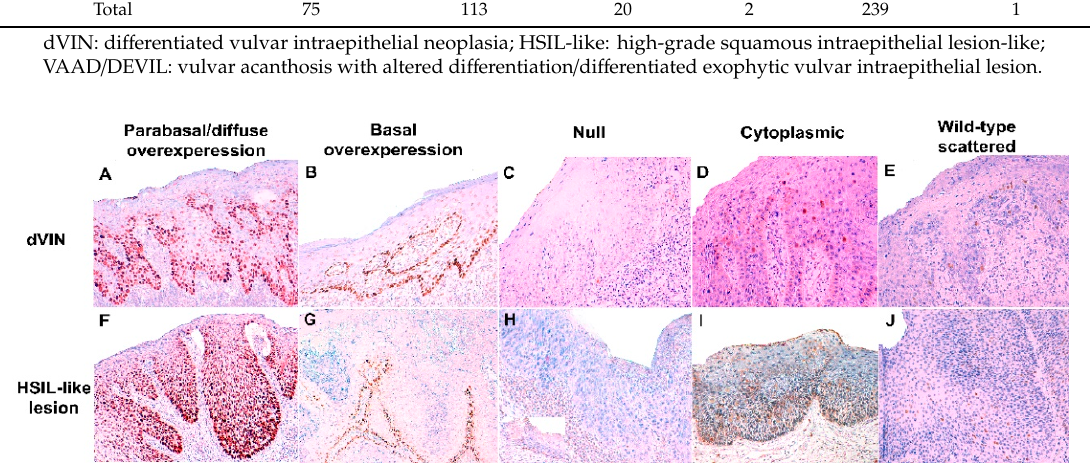
Figure 1. Examples of abnormal and wild-type p53 immunohistochemical expression in the two types of intraepithelial lesions. ( A – E ) Differentiated vulvar intraepithelial neoplasia (dVIN), and ( F – J ) high-grade squamous intraepithelial-like lesion (HSIL-like). Each column shows, respectively, the following pattern: First column, parabasal overexpression; second column, basal overexpression; third column, null; fourth column, cytoplasmic; fifth column, wild-type scattered pattern (p53 IHC immunostaining with hematoxylin counterstain, original magnification: 100×).